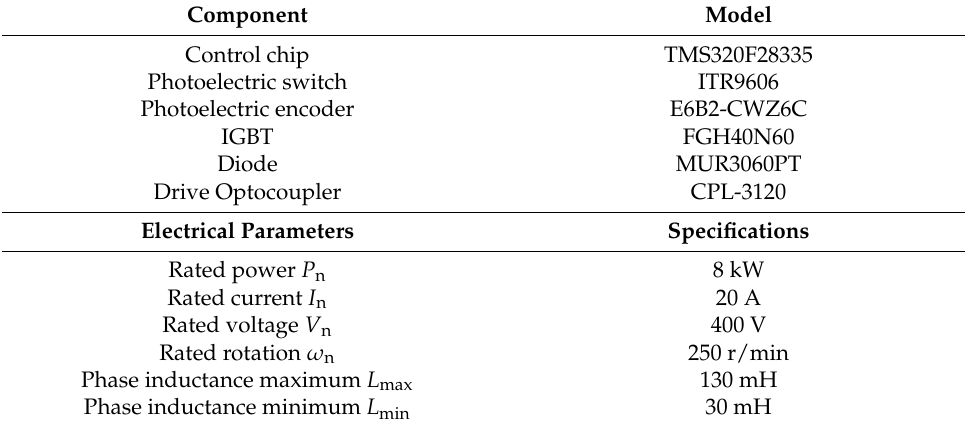
Figure 11. Experimental platform. ( a ) Machine system; ( b ) Driver system. Hardware components and parameters are shown in Table 1. Table 1. Hardware specifications.